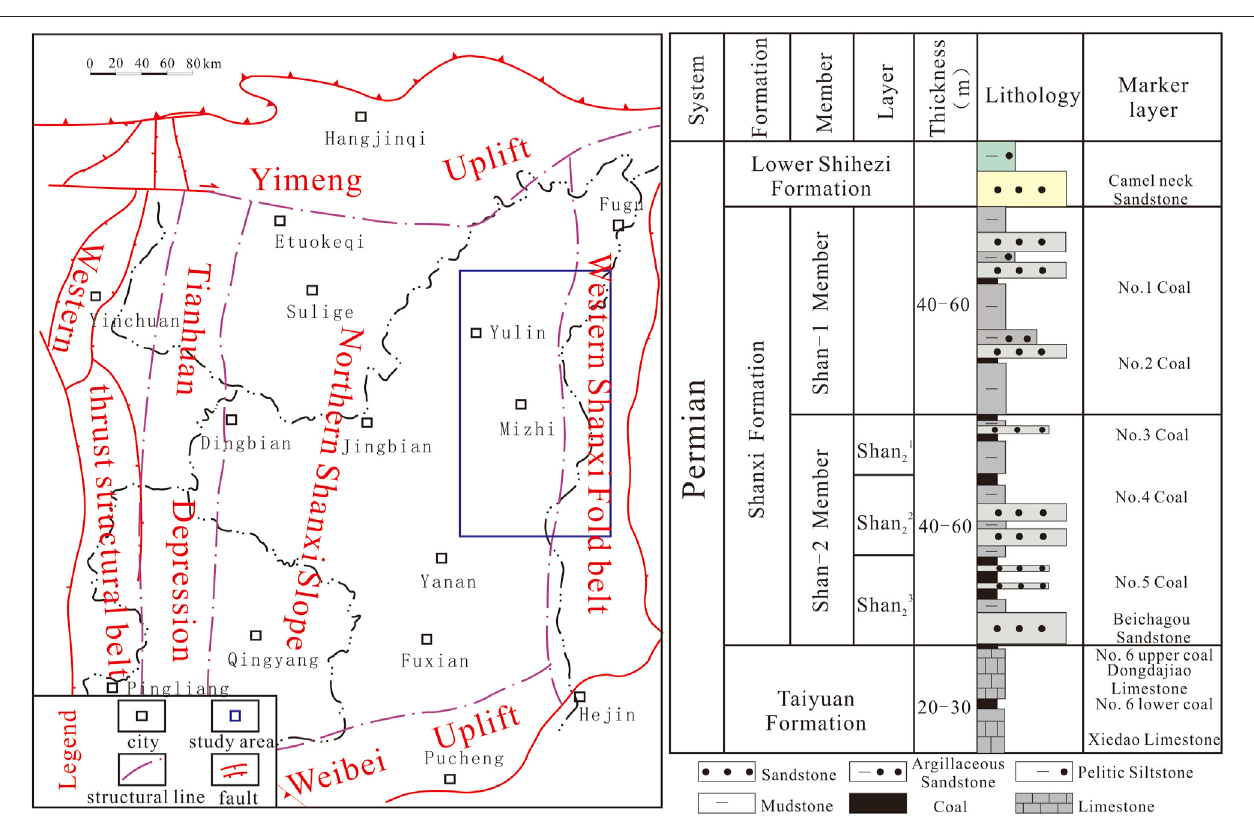
FIGURE 1 | Location of the study area and lithologic histogram of the Shanxi Formation.